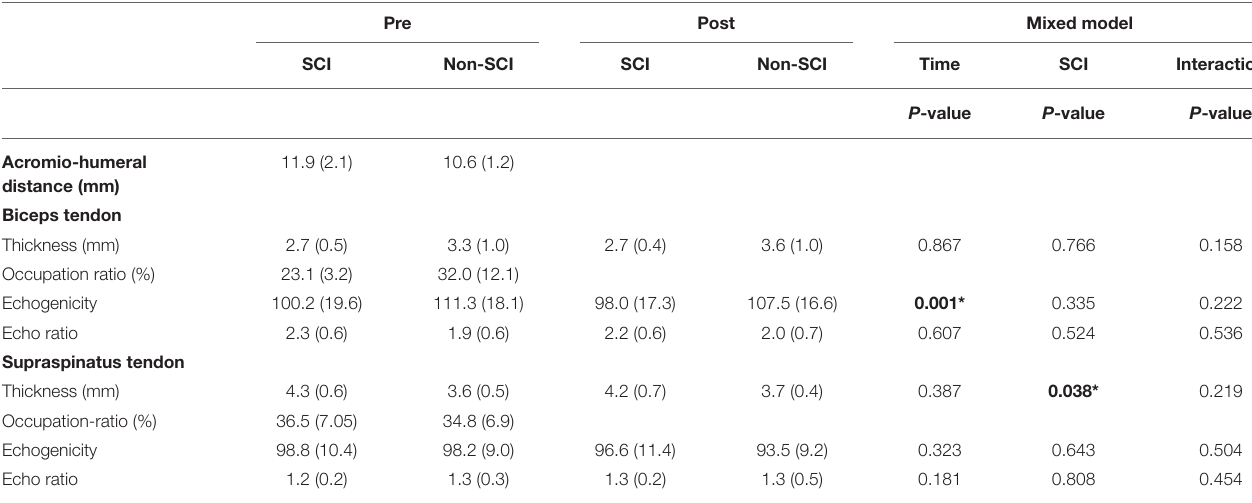
TABLE 2 | Unadjusted characteristics [mean (SD)] of the biceps and supraspinatus tendon pre- and post- a fatiguing bout of exercise, the occupation ratio, and acromio-humeral distance (AHD) in WR players with SCI and Non-SCI. Pre